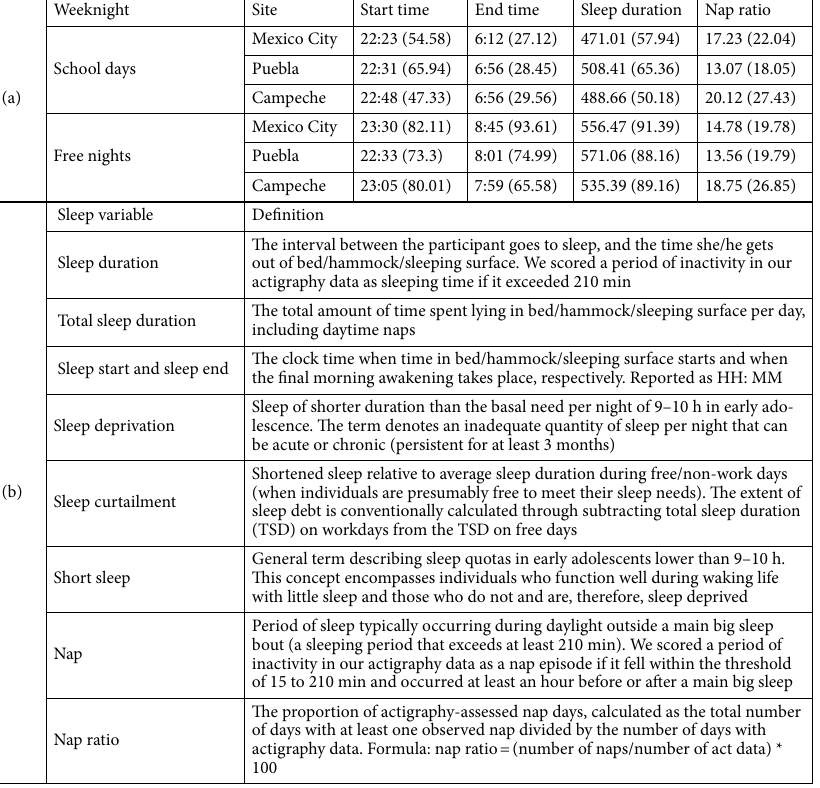
Table 3. (a) Values for sleep timing, duration and daytime napping by sites. Data are represented in minutes as mean (standard deviation). Standard deviation is expressed in minutes for start times, end times and sleep values. (b) Definitions of sleep